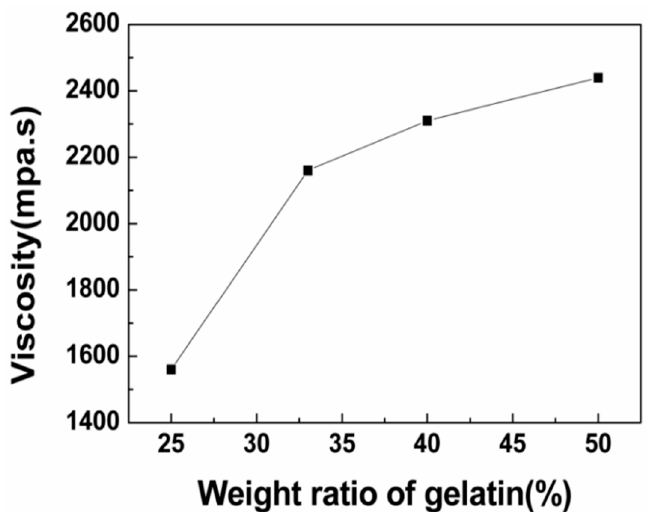
Figure 1. The relationship between the viscosity of the spinning solution and the weight ratios of gelatin (total polymer concentration = 25% w / v ).